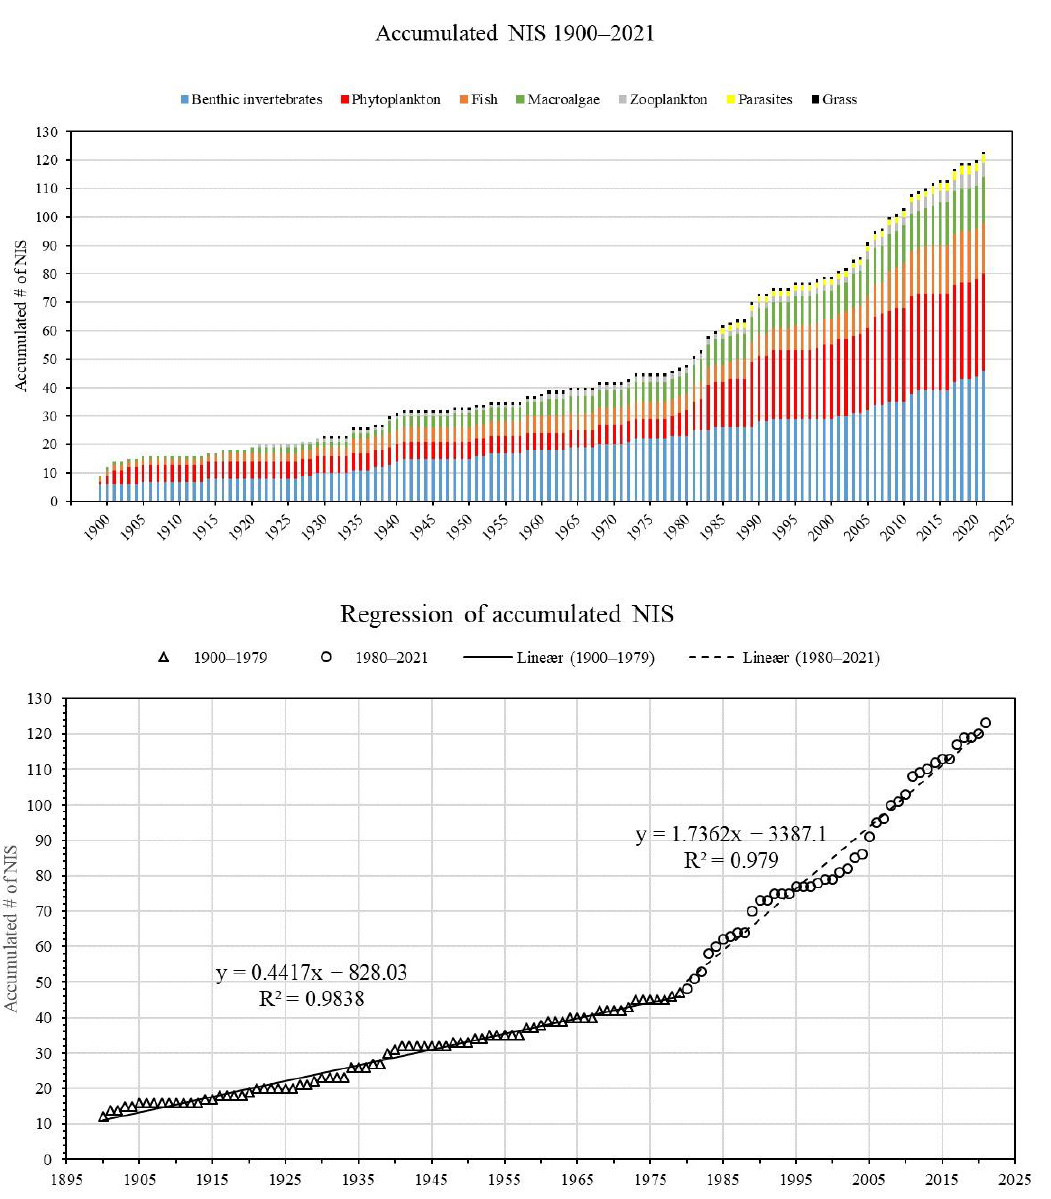
Figure 5. Top : the accumulated number of NIS divided into functional groups. Bottom : regression of accumulated number of NIS. There is a distinct increase in slope around 1980. The nine NIS recordings before 1900 are excluded from the regression analysis.